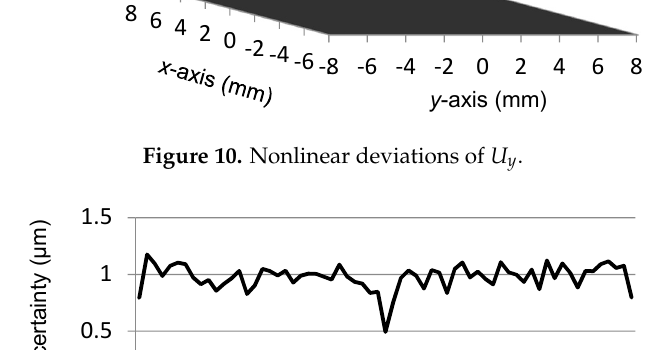
Figure 10. Nonlinear deviations of U y .